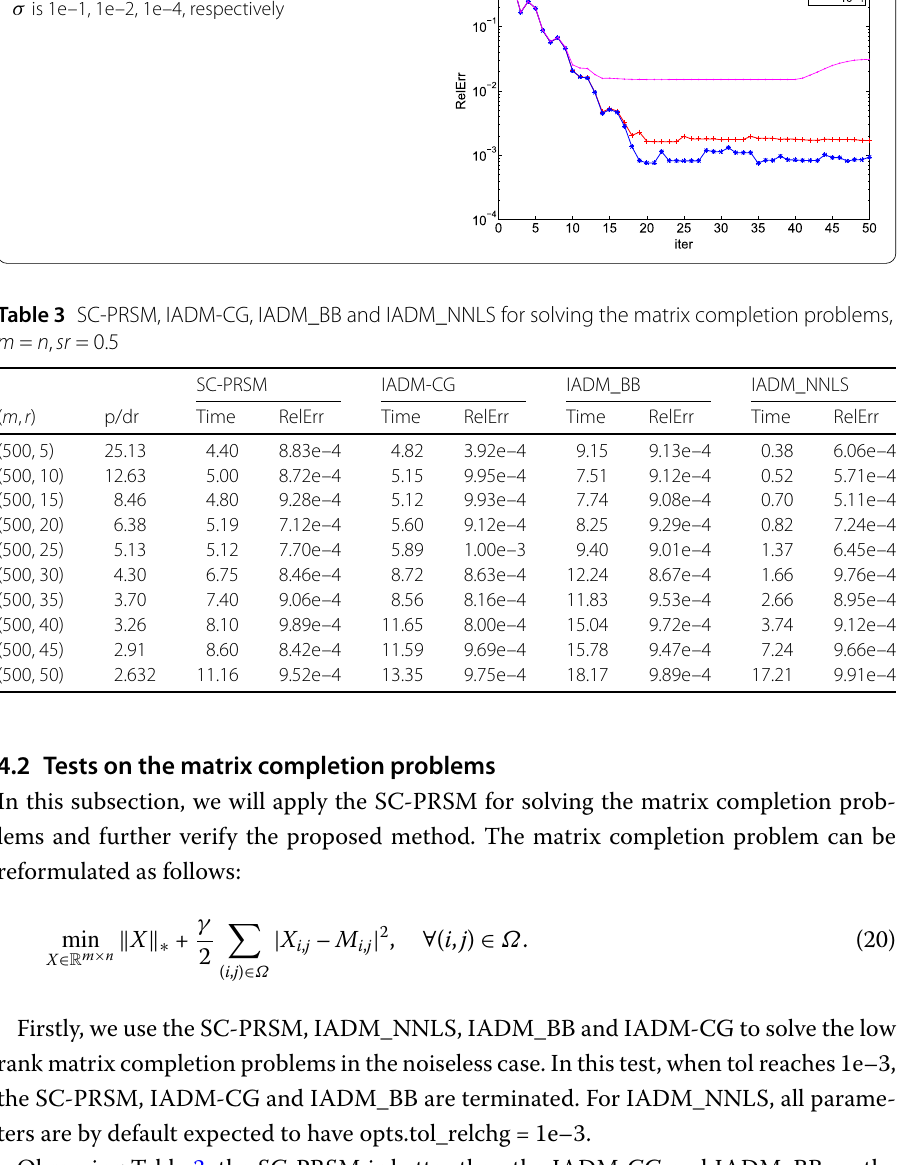
Figure 3 SC-PRSM for the nuclear norm minimization with noise ( m = n = 200, r = 5, sr = 0.5), σ is 1e–1, 1e–2, 1e–4, respectively